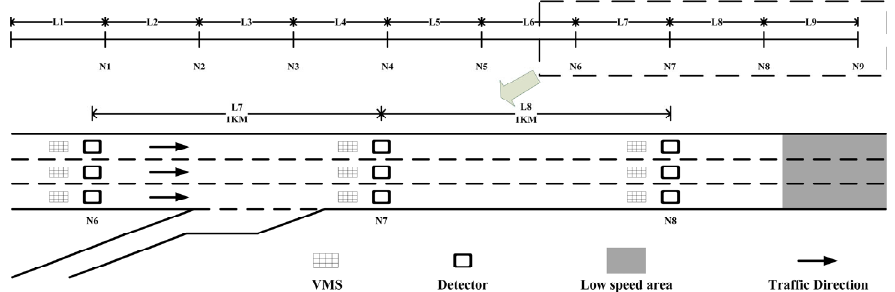
Figure 2. Illustration of the simulation road. Table 1. Parameter settings of simulation experiments.